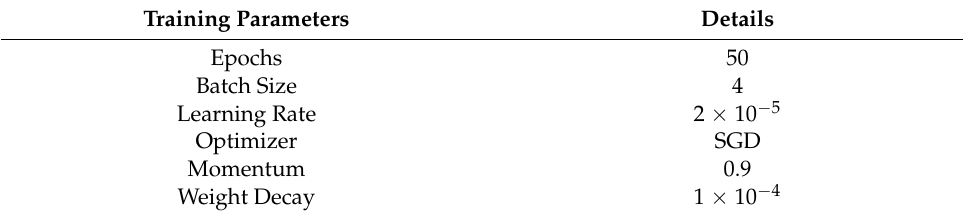
Table 2. Training parameters.